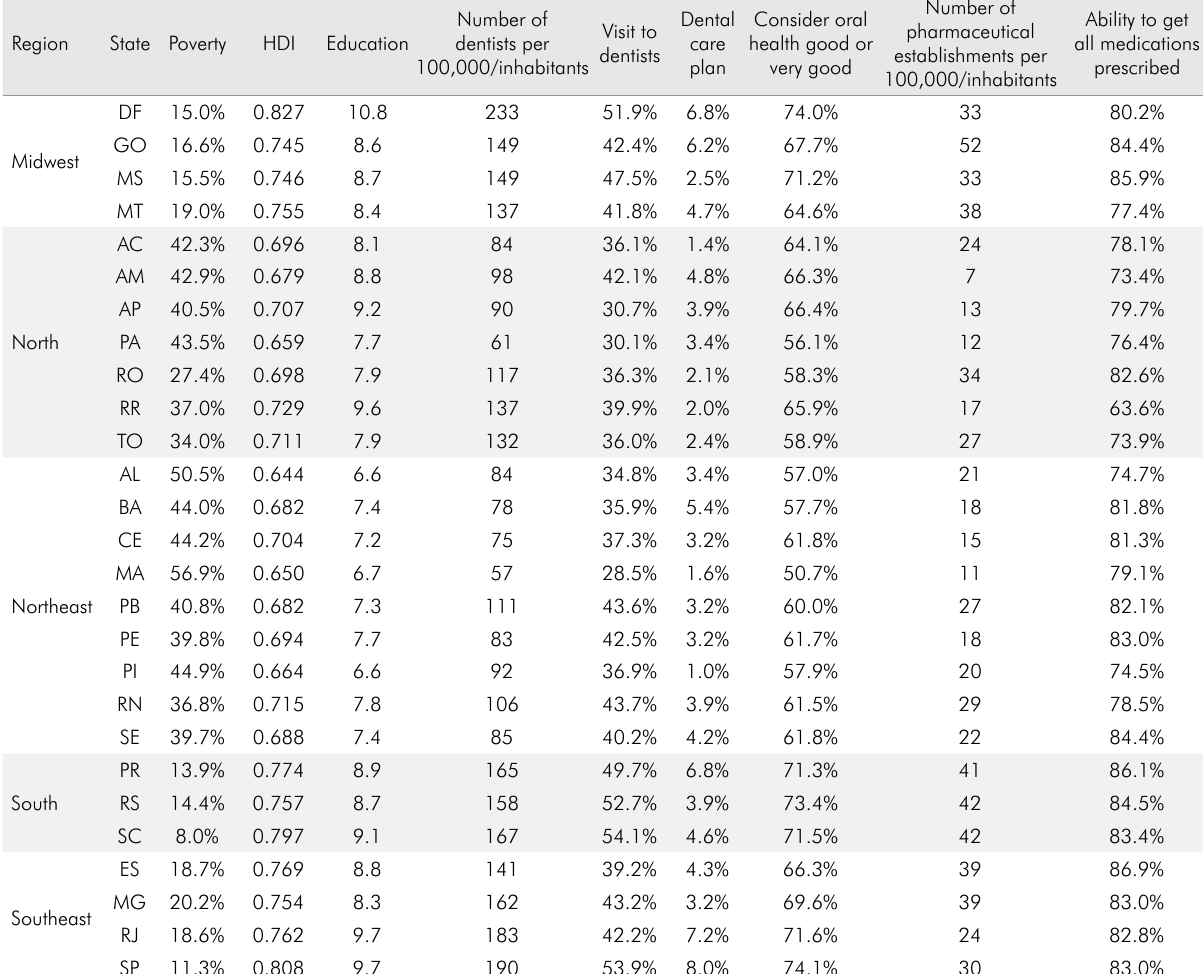
Table 3. Socioeconomic, oral health and medication indicators by Brazilian states.